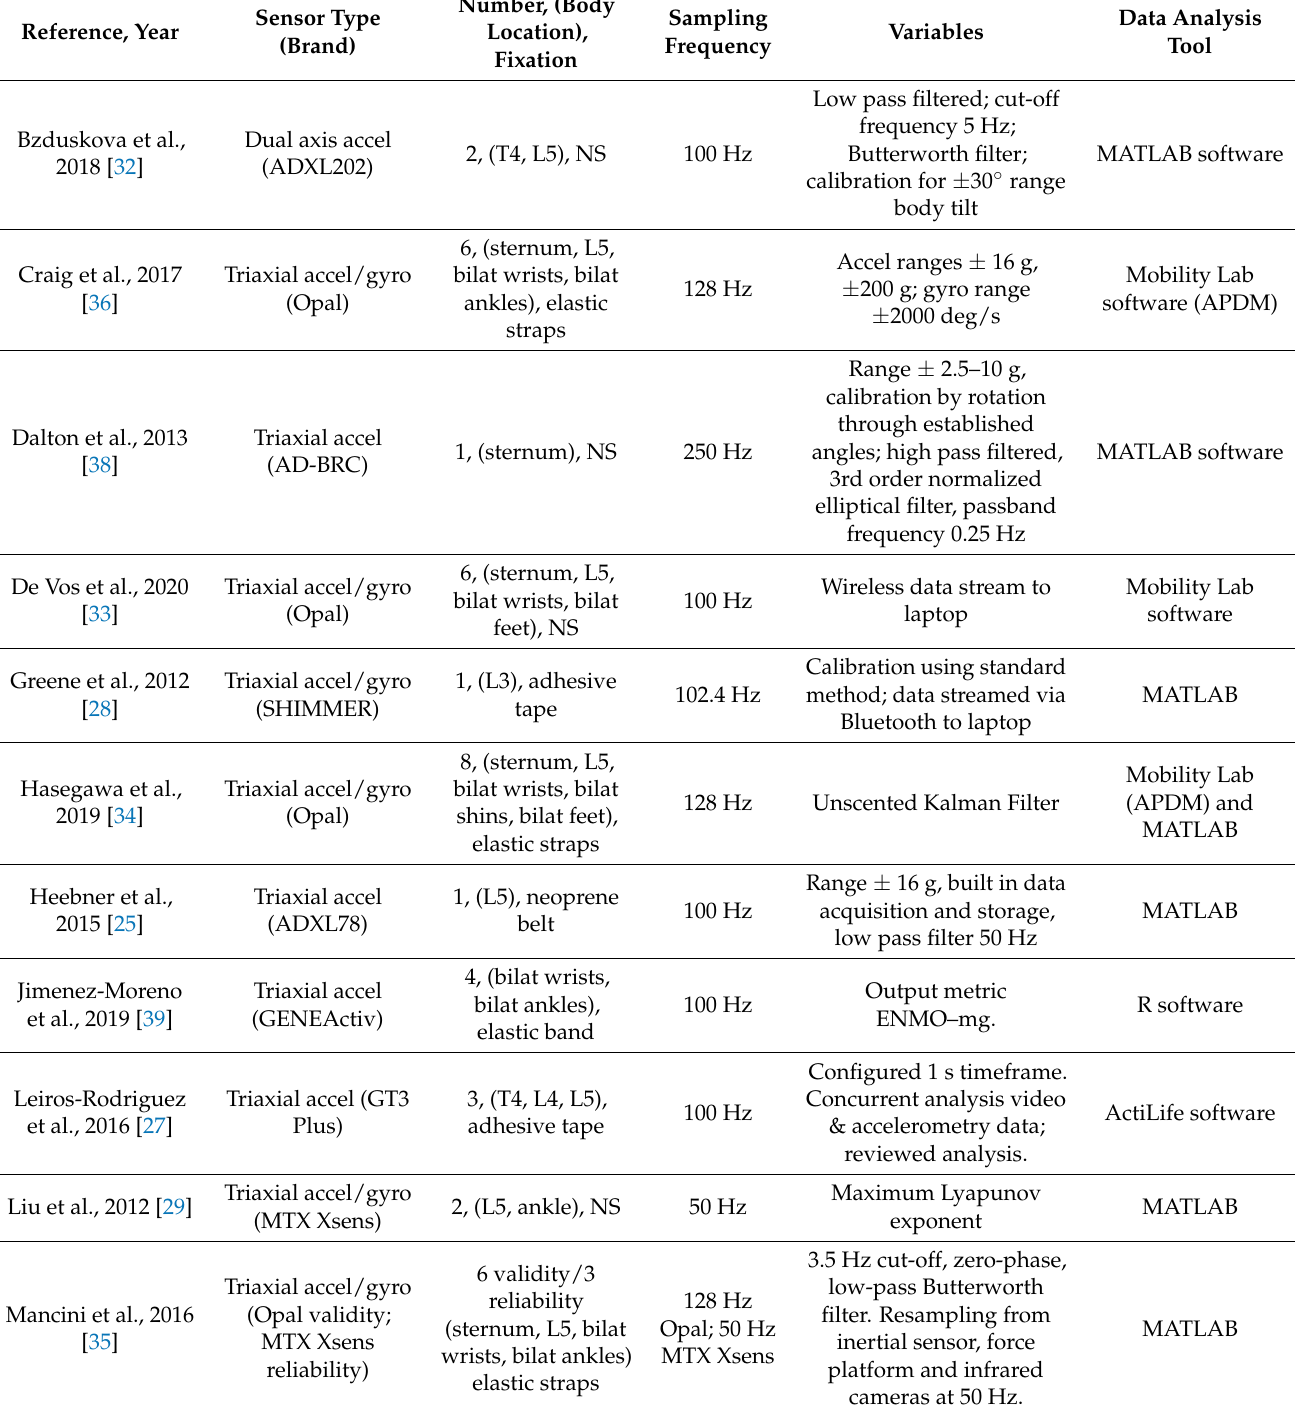
Table 3. Sensors